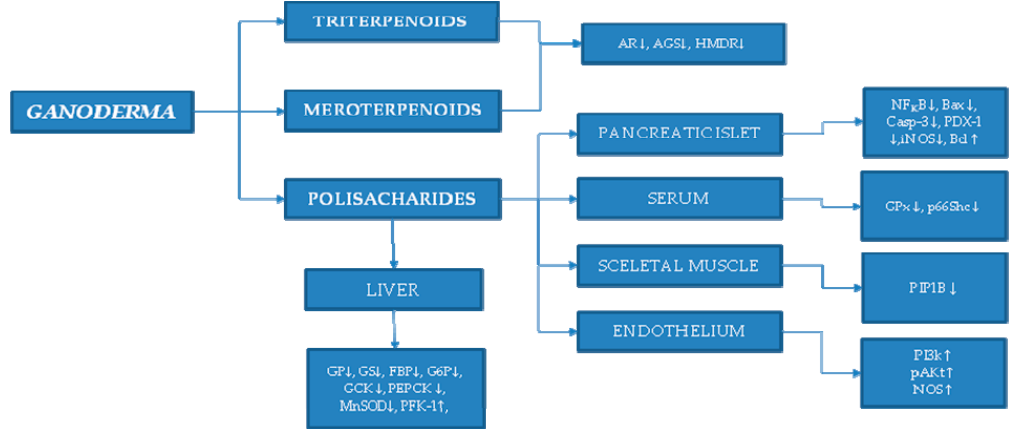
Scheme 1. The antidiabetes activity of Ganoderma .